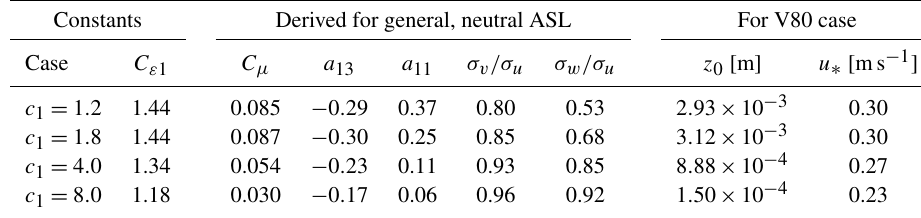
Table B1. Tested sets of turbulence model constants and derived variables for the single-wake V80 case. For all sets, we use C ε 2 = 1 . 82, σ k = 1 . 0, σ ε = 1 . 3, κ = 0 . 38, and c 2 = 5 . 9